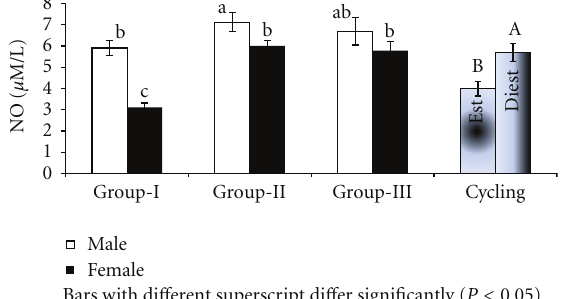
Figure 5: NO in culture supernatant supplemented with di ff erent levels of progesterone in Murrah bu ff aloes.